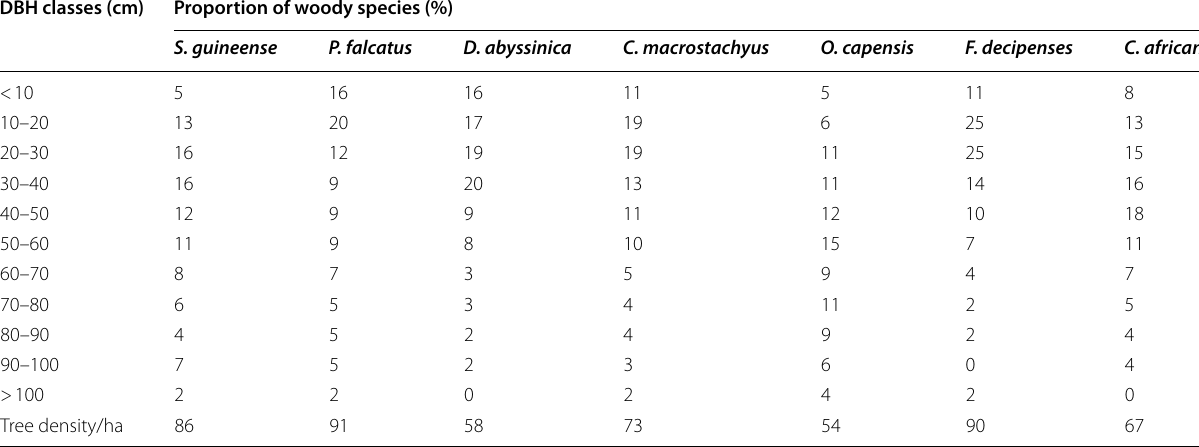
Table 2 Stem density of each tree species per ha and its proportion in the Harana forest DBH classes